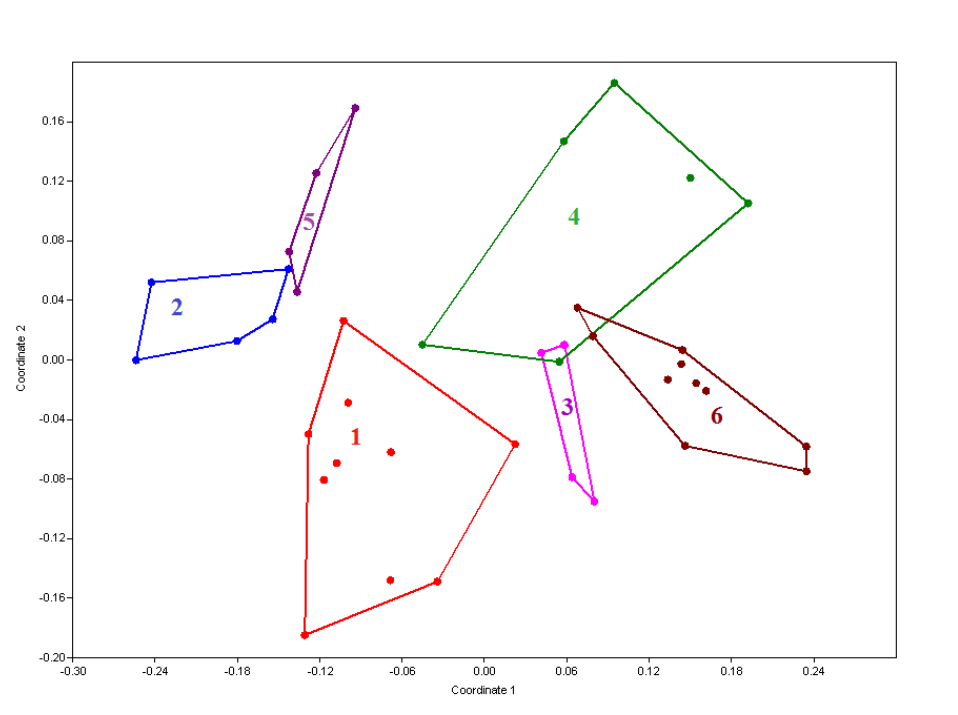
Fig. 5. MDS plot of L. peltata populations studied based on ISSR data (Populations 1-6 are according to Table